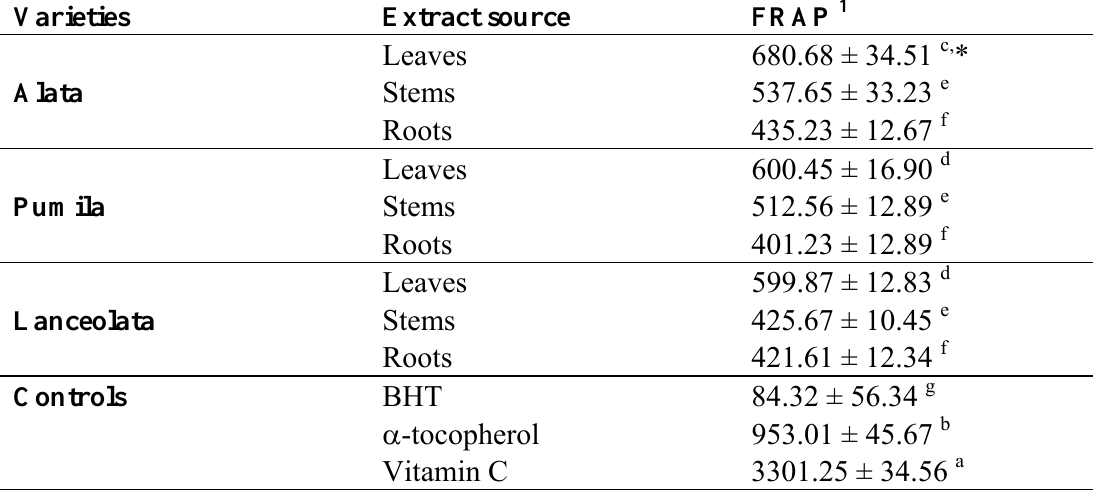
Table 2. Total antioxidant (FRAP) activity in different parts of three varieties of L pumila . BHT, α -tocopherol and vitamin c were used as positive